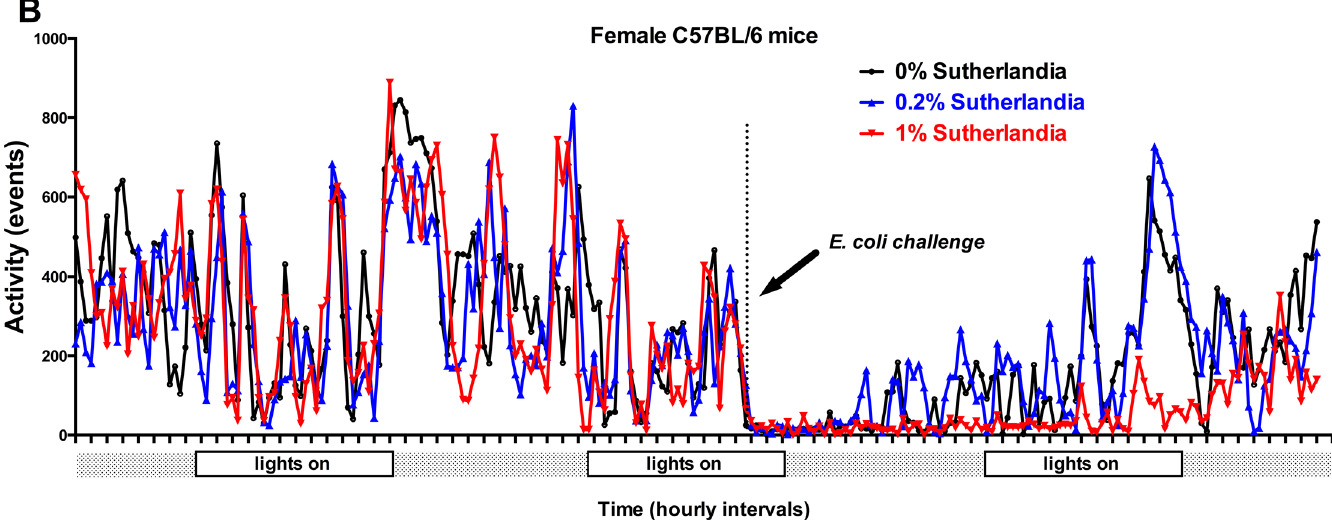
Fig 4. Dietary S . frutescens Has No Impact on Spontaneous Activity (i.e., sickness behavior) of Mice After an Experimental Infection with E . coli . Conditions were similar to those described in Fig 3, except in this experiment the mice were C57Bl/6 mice and the challenge consisted of an intraperitoneal injection with ~10 8 cfu of E . coli (K-12